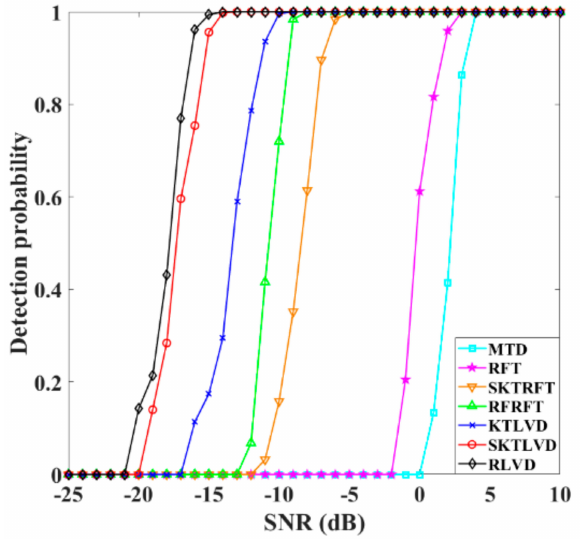
Figure 6. Detection probability of different methods.